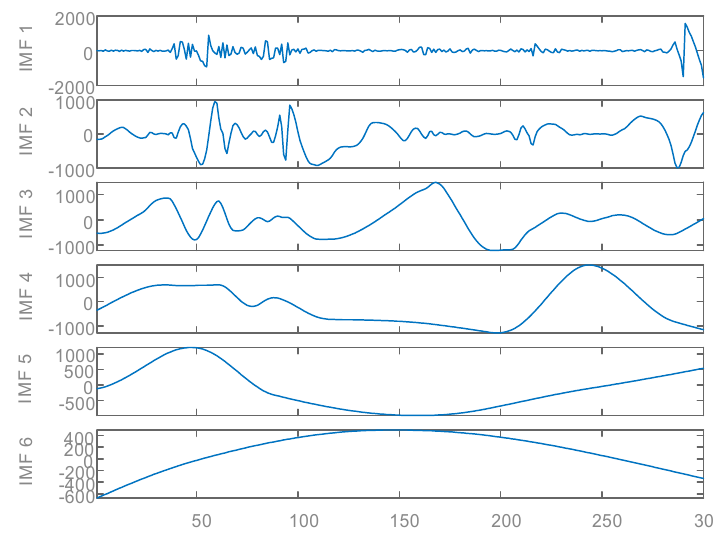
Figure 8. Types of samples with severe weather changes exploded view.